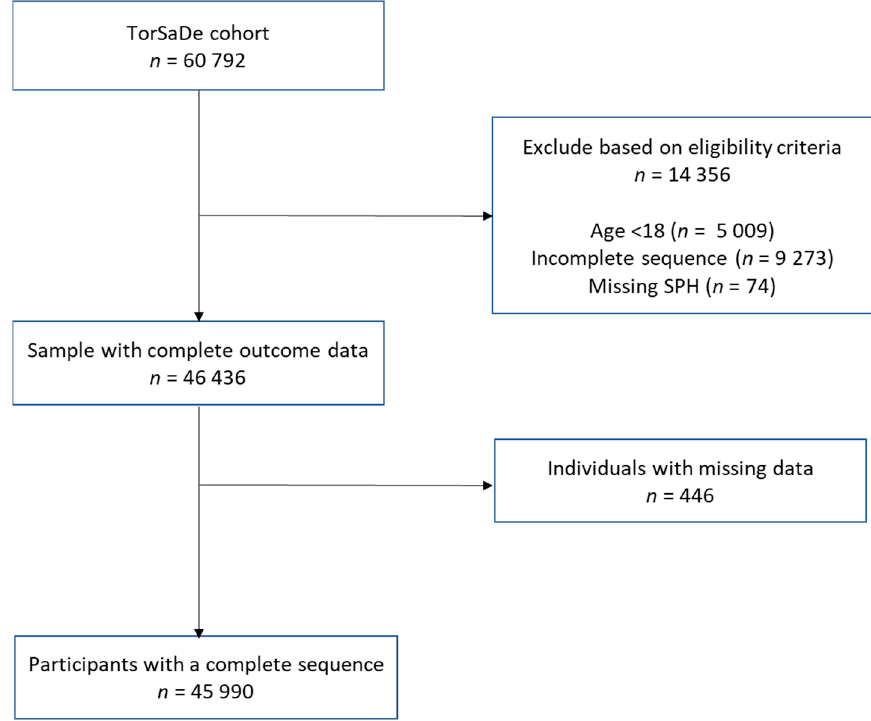
Figure 1. Exclusion flow chart of analytic sample.